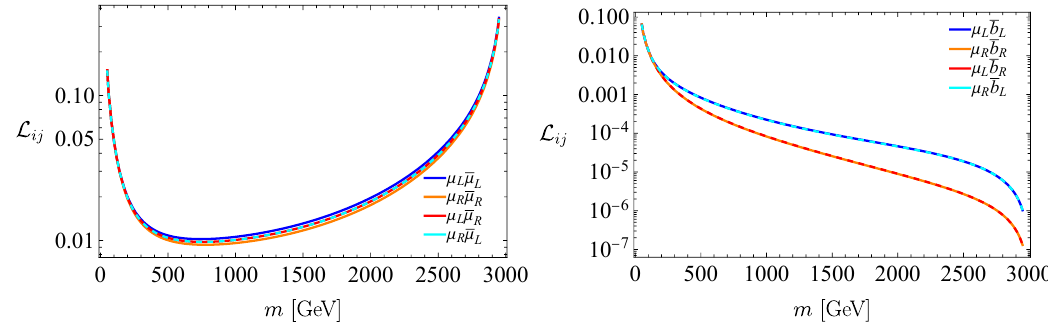
√ s 0 = 3 TeV, involving two muons (left) or a muon and a